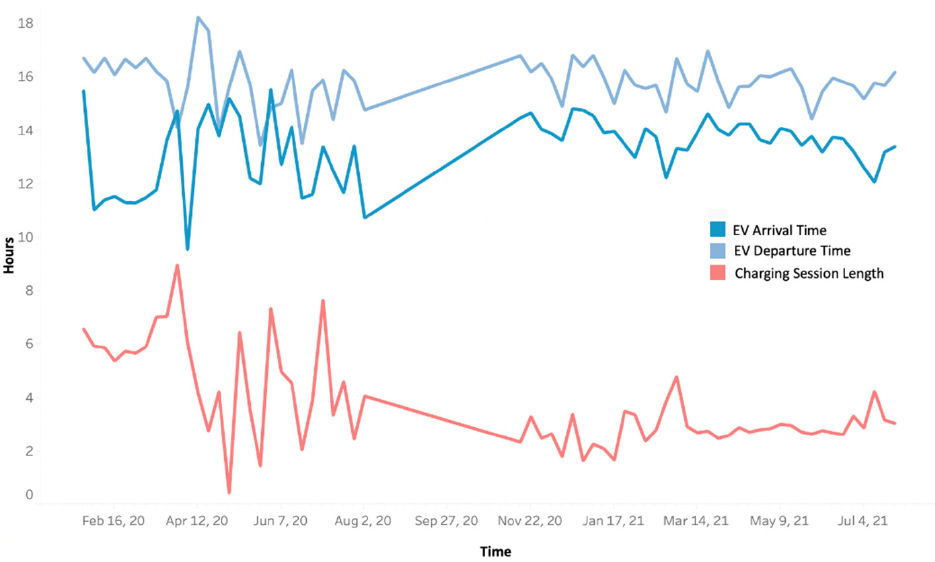
Figure 1. Charging activity by month during COVID-19.